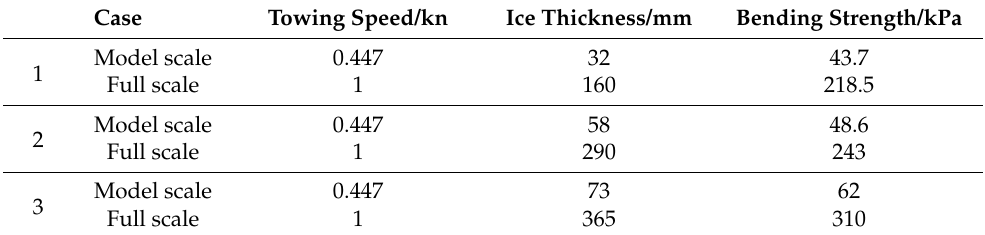
Table 2. Main parameters.